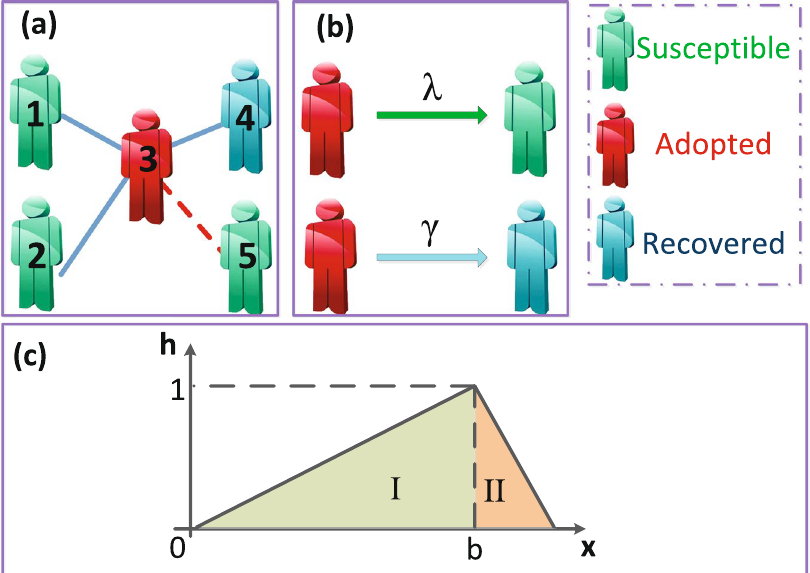
Figure 1. ( a ) Illustration of social contagions on complex networks. ( b ) Schematic of information transmission from the adopted individual to his each susceptible neighbor with probability λ and state change from being adopted to recovered with probability γ . ( c ) Tent-like behavior adoption probability. Notations b and x indicate local trend imitation capacity and the ratio of adopted informants, respectively. In region I, the adoption probability increases with x . In region II, the adoption probability decreases with x